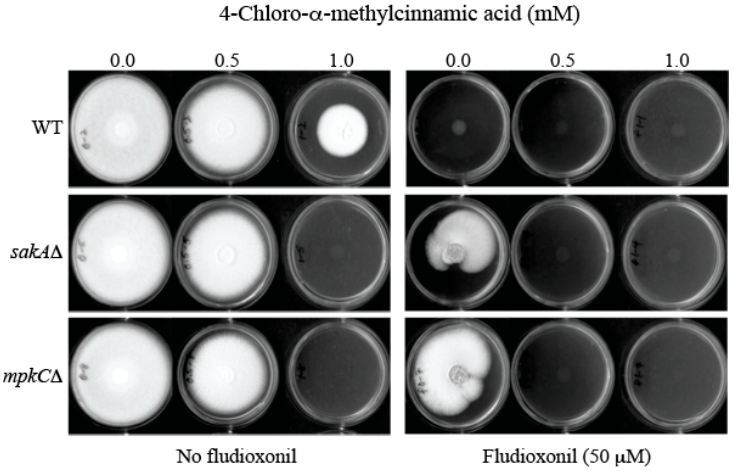
Figure 4. Overcoming fludioxonil (50 μ M) tolerance of A. fumigatus mitogen-activated protein kinase (MAPK) mutants ( sakA Δ , mpkC Δ ) by 4-chloro- α -methylcinnamic acid (0.5 mM).